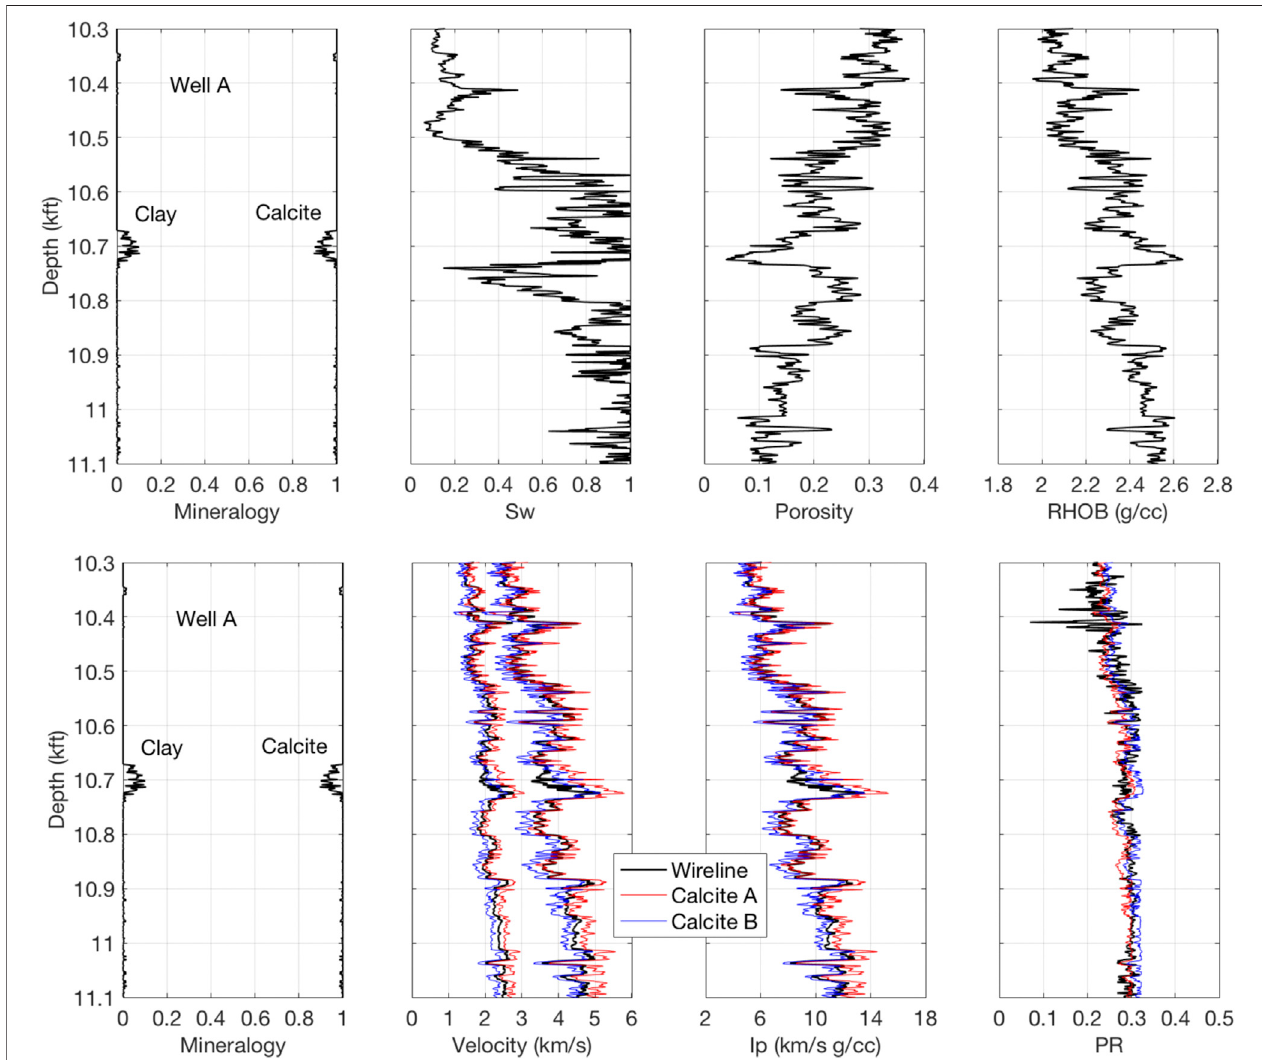
FIGURE 5 | Wireline curves at in-situ conditions for Well A (top) with the stiff-sand model curves (bottom) shown in the velocity, impedance, and Poisson ’ s ratio frames using the Calcite A (red) and Calcite B (blue) inputs.